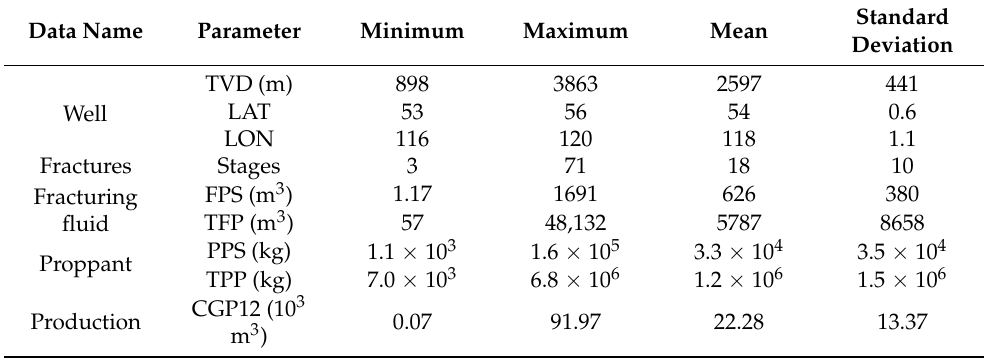
Table 4. Summary statistics of numerical